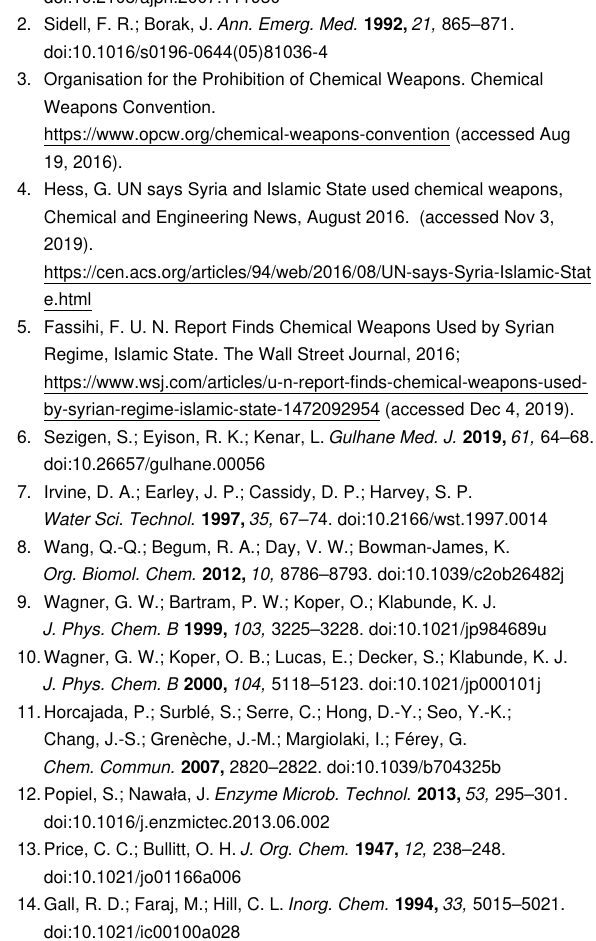
The photocatalytic oxidation reaction takes place without noticeable degradation of NU-400, as evidenced by PXRD anal- ysis following four cycles of CEES to CEESO oxidation, which reveals a high degree of crystallinity (see Figure S7, Support- ing Information File 1). At the same time, no overoxidation of CEES to 2-chloroethyl ethyl sulfone (CEESO 2 ) was observed, as demonstrated by 1 H NMR spectroscopy (Figure S6, Support- ing Information File